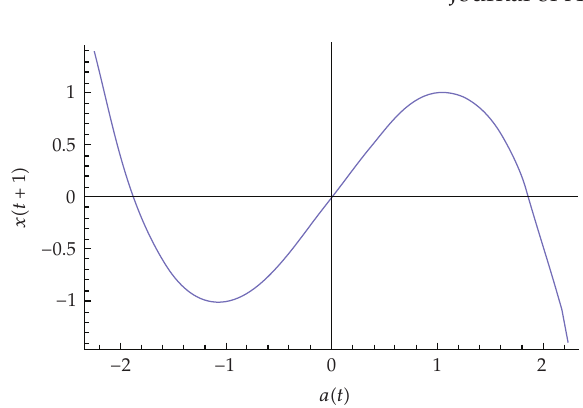
Figure 6: Transmission function for a value of δ (cid:8) 0 .